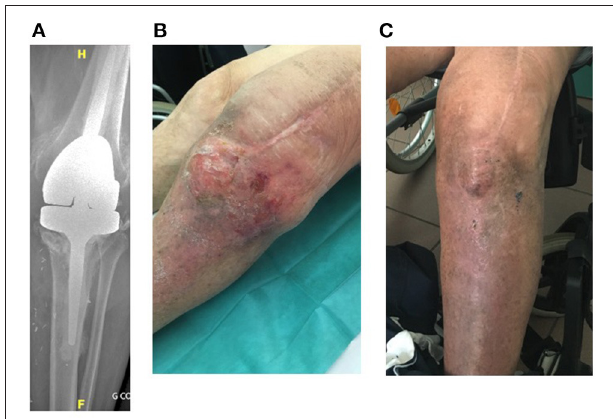
FIGURE 4 | Patient 4 was an 83-year-old man with a history of severe cardiomyopathy requiring anticoagulation, dyslipidemia, and diabetes. He had a left-cemented revision prosthesis (A) following a two-stage exchange for PKI due to Streptococcus spp. He experienced postoperative chronic septic arthritis due to S. epidermidis (5/23/2018), and he was treated by open DAIR, skin and soft tissue flap, and SAT (clindamycin plus levofloxacin followed by clindamycin plus cotrimoxazole). Under SAT, the patient experienced a relapse of the septic arthritis (B) due to MDR S. epidermidis (19/07/2018). He was treated according to the LysinDAIR procedure (10/01/2019) and received daptomycin intravenously and linezolid orally. He developed eosinophilic pneumonia attributed to daptomycin before the switch to tedizolid. During the follow-up, the clinical signs of septic arthritis totally disappeared. At the time of writing (14 months of follow-up after the LysinDAIR procedure), the clinical outcome was still favorable under tedizolid (C) .